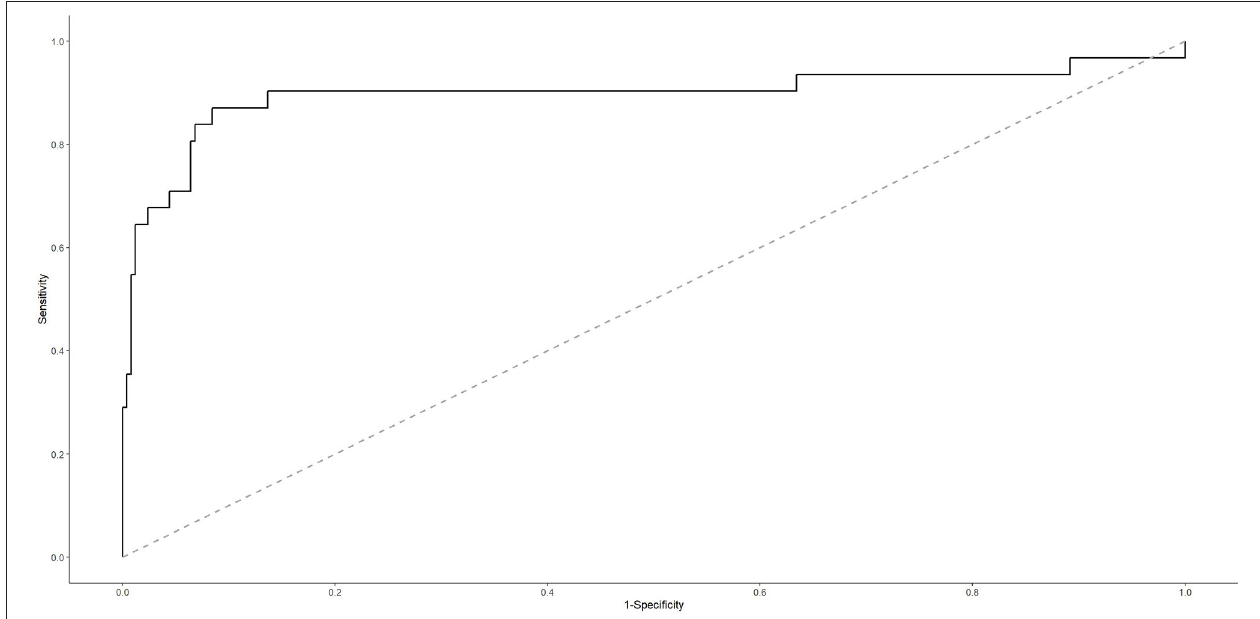
FIGURE 5 | Area under the receiver operating characteristic (AUROC) curve for cervical ADC